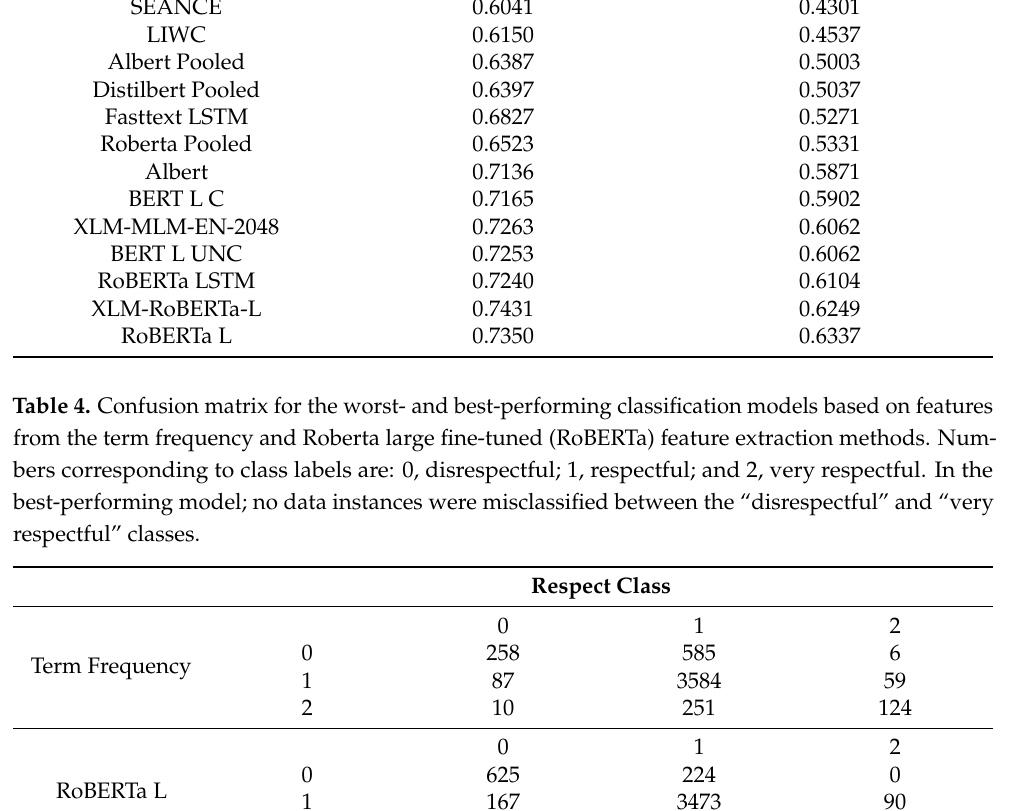
Table 3. F1 macro and MCC scores of the compared models.